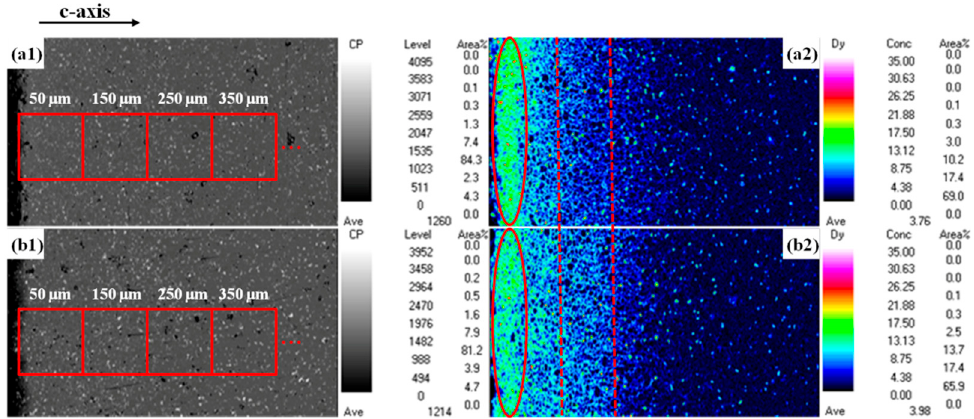
Figure 7. The SEM images and the corresponding EPMA mapping (parallel to c-axis) at 0–400 μ m of ( a1 , a2 ) Dy 70 Al 10 Ga 20 and ( b1 , b2 ) (Pr 75 Dy 25 ) 70 Al 10 Ga 20 diffused magnets, respectively.